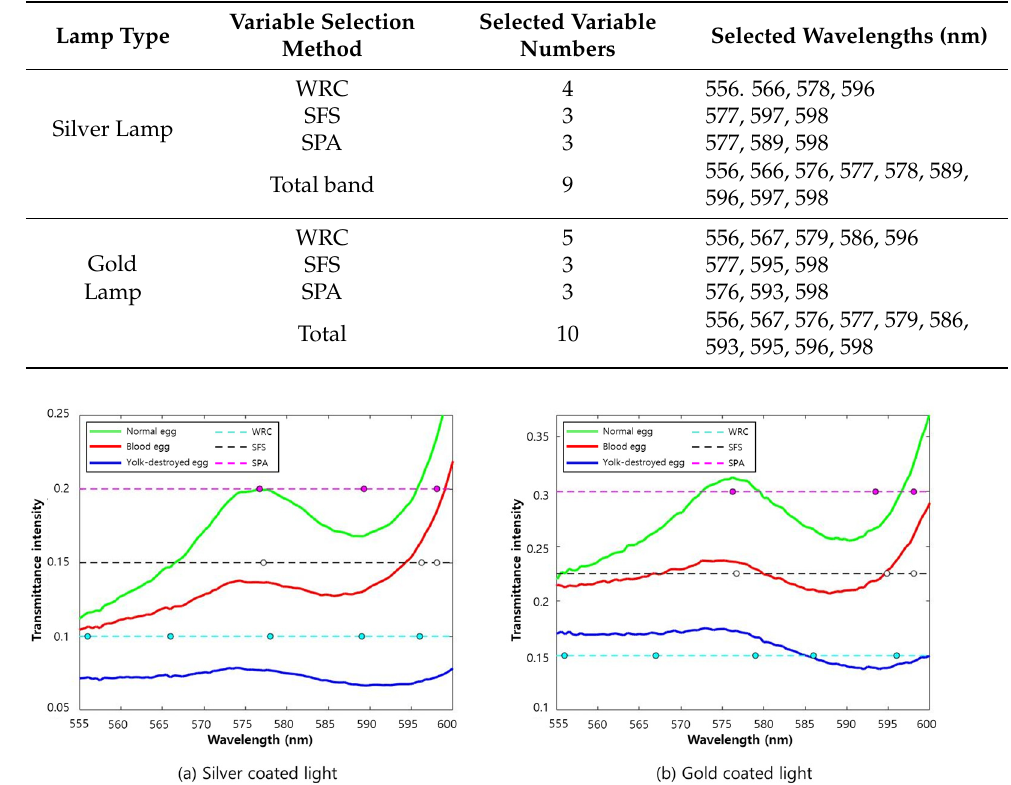
Table 2. The selected wavelengths for identifying the abnormal eggs using different variable selection methods.